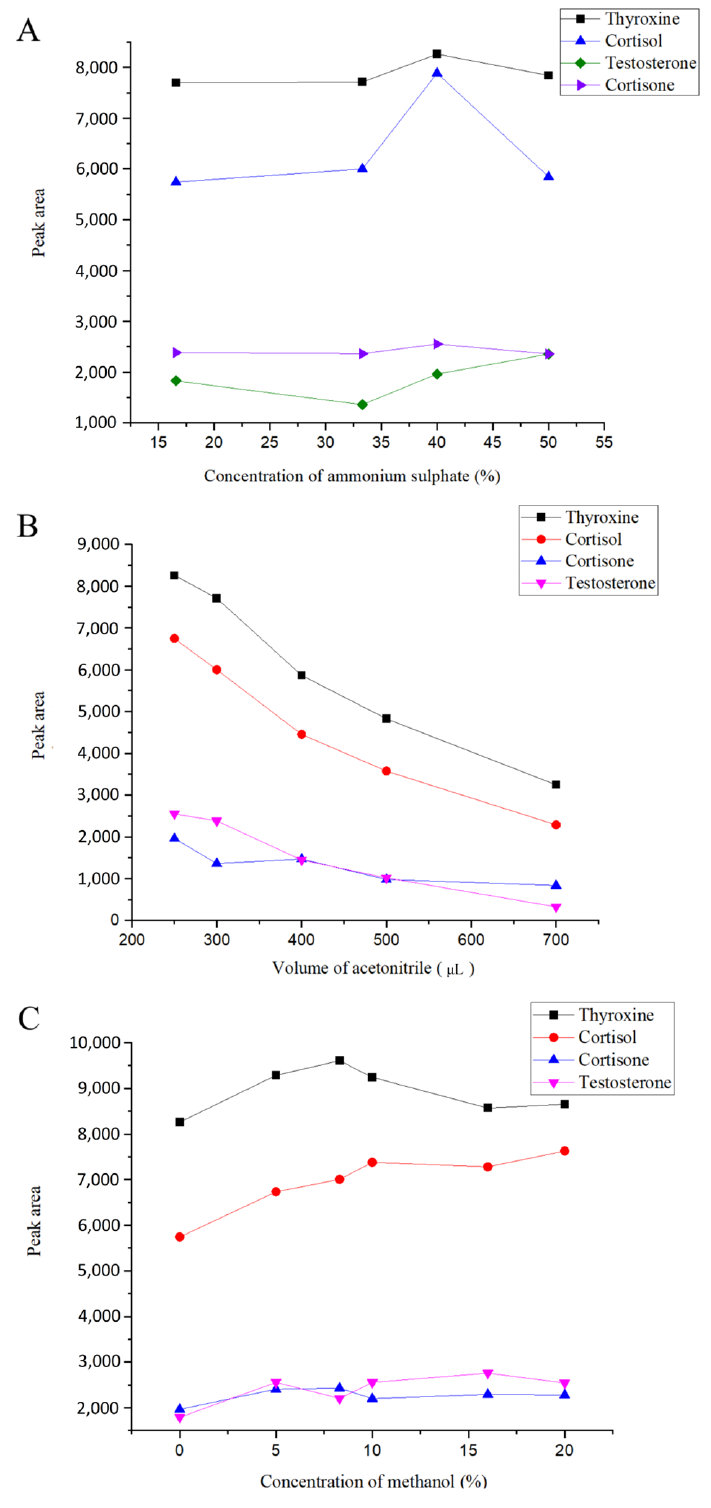
Figure 2. Effect of different optimization parameters on the SALLE extraction recovery as measured by peak area response ( n = 3 for all). ( A ) The effect of saturated ammonium sulfate solution when added to different concentrations, ( B ) the effect of acetonitrile (ACN) volume, and ( C ) the effect of methanol concentration in the acetonitrile.